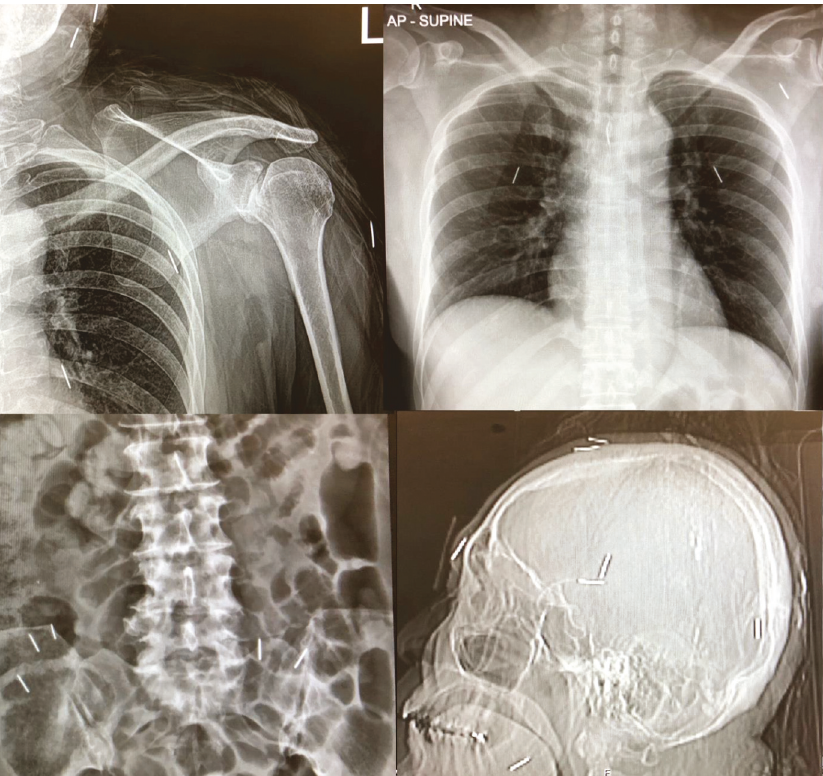
Figure 2: Plain X-ray exhibiting many 1cm pin-like metallic opacities at the posterior chest wall, paraspinal area of the lumbosacral spines, and